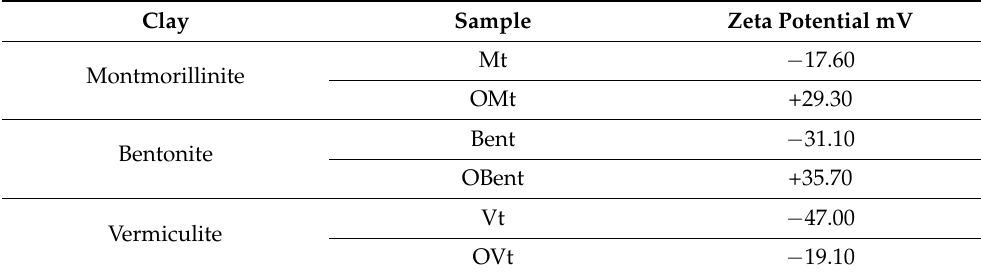
Table 1. Surface charge of pristine and